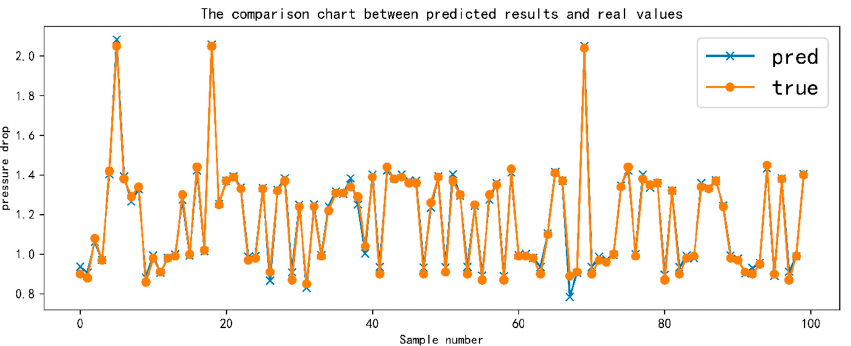
Figure 10. Comparison of predicted and real values.